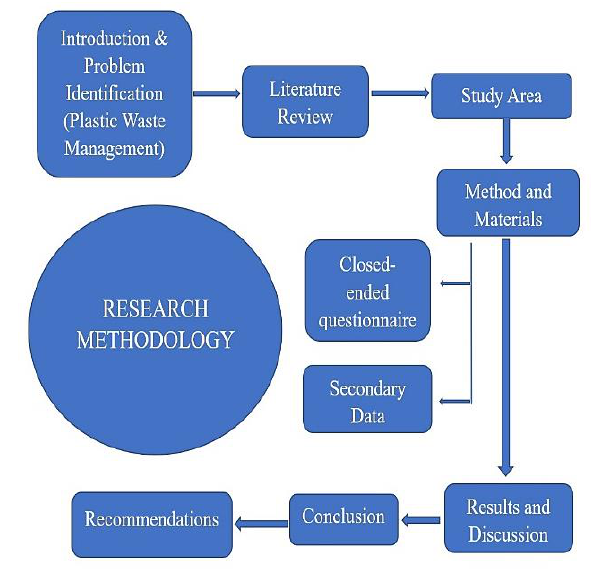
Fig. 2. Research methodology flow chart (source: researcher)